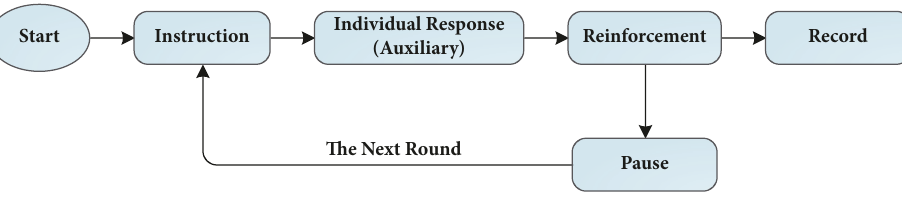
Figure 2: The basic process of DTT for children with ASD.